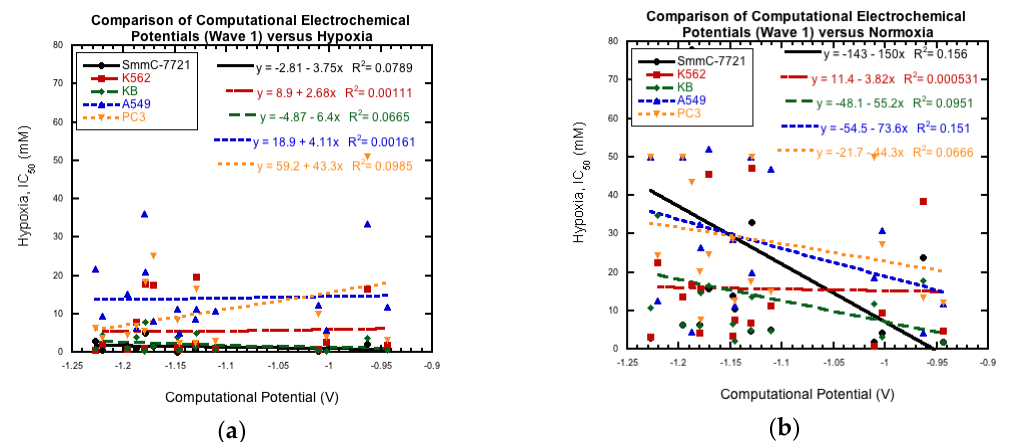
Figure 11. The computationally derived reduction potentials from 6-31g for Wave 1 (1st N-oxide reduction) and compared to the previously reported IC 50 ( µ M) for five cancer cell lines [26] under ( a ) hypoxic and ( b ) normoxic conditions for A1–D4. Hypoxia = 3% oxygen, Normoxia = 20% oxygen.